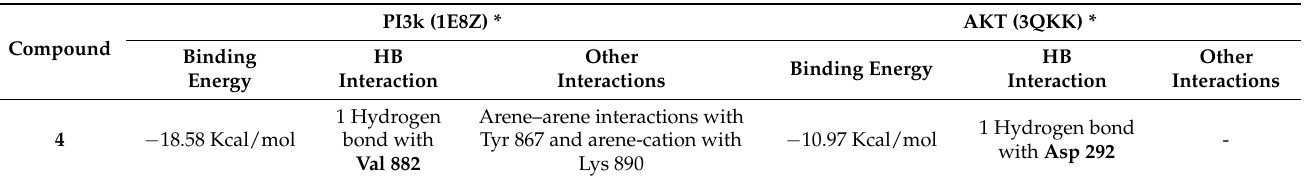
Table 5. Analysis of ligand – receptor interactions with binding energies of docked compounds 4 towards PI3K and AKT proteins.